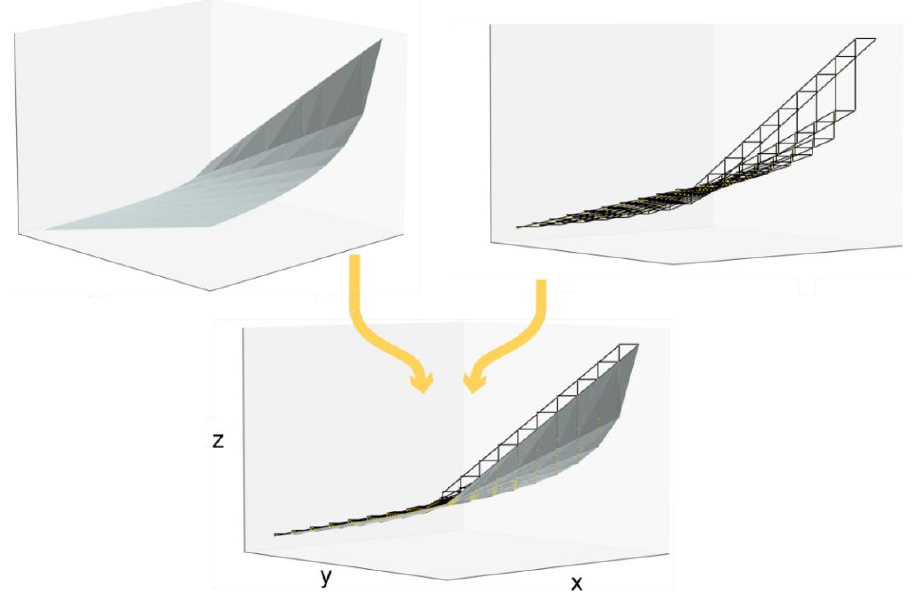
Figure 4. Exemplary approximation mesh of z = f ( x , y ) = y